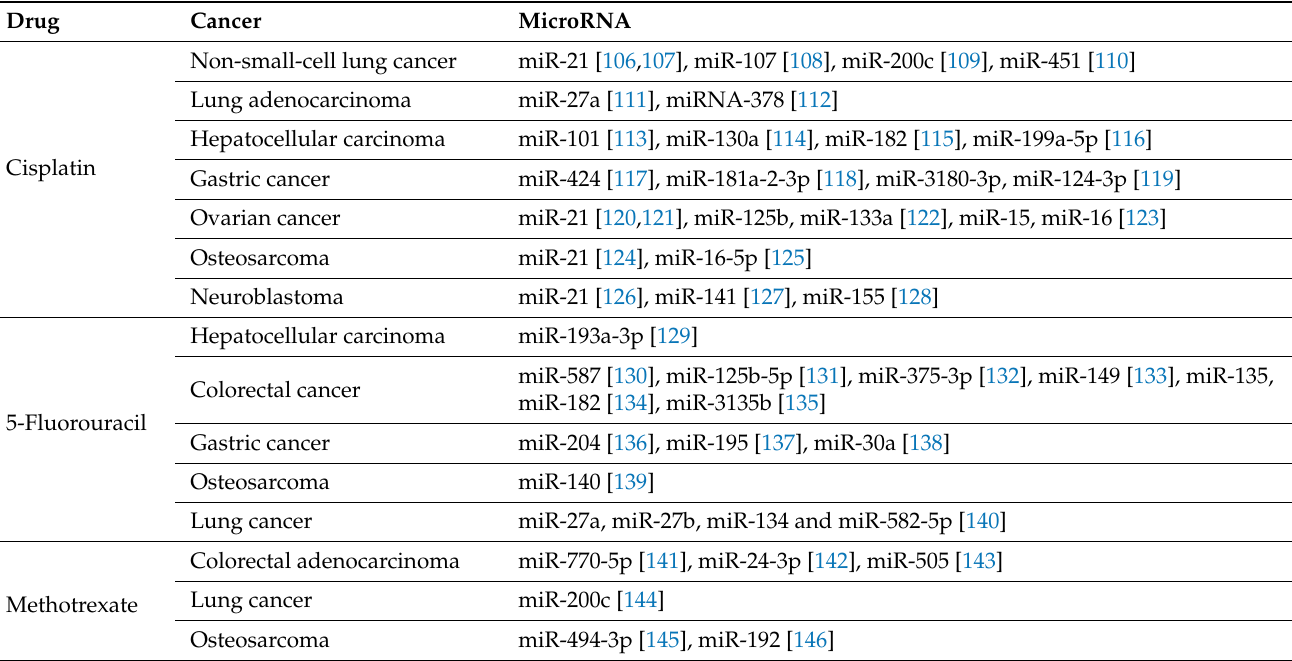
Table 2. Marker miRNAs involved in anticancer drug insensitivity mechanisms in human solid